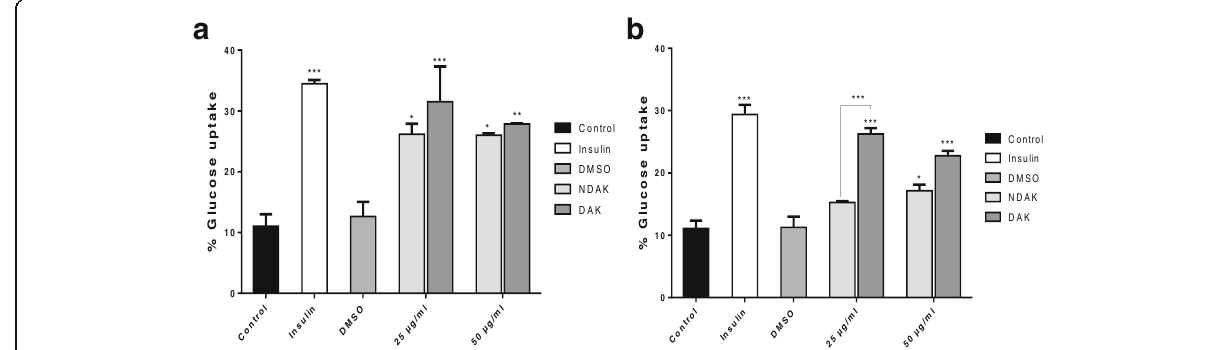
Fig. 1 Glucose uptake by C2C12 muscle ( a ) and 3T3-L1 adipose cells ( b ) following 3 h treatment with extracts of A. karroo . Insulin at 3000 mIU/ml was used as a positive control. Untreated cells and DMSO were used as standard controls. NDAK = Non-defatted extract of A. karroo , DAK = Defatted ex- tract of A. karroo . The results are presented as ± SEM from triplicate of three independent experiments. The statistical significance of the results was tested using One-way Analysis of Variance (ANOVA) employing the Turkey-Kramer multiple comparison test between the control and different groups and between groups. The results were considered significant at (*) P < 0.05, (**) P < 0.01 and (***) P < 0.001